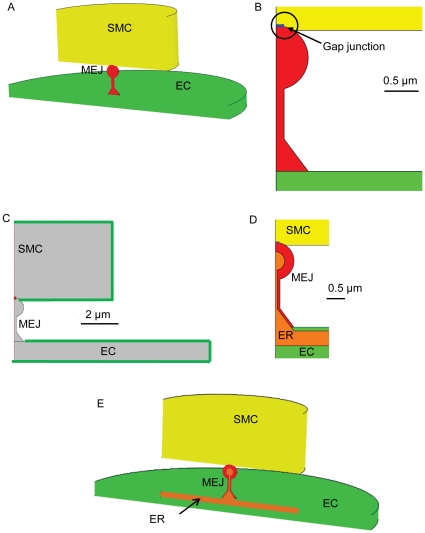
Description of the models.A, B) Model of the interaction between a smooth muscle cell (SMC) and an endothelial cell (EC) through the myoendothelial junction (MEJ). The SMC is shown in yellow, the EC in green and the MEJ in red. The SMC and MEJ are coupled in the area highlighted with the black circle at the blue edge. B,C) The endothelial cell (EC) has a radius of 10 µm and is 1 µm thick. The smooth muscle cell (SMC) has a radius of 5 µm and is 4 µm thick. The head of the MEJ is spherical with a radius of 0.5 µm that is located on top of a neck that is 1.525 µm long. Stimulation was modeled by increasing the concentration at the green boundaries in the respective cell. Scale bars indicate the respective dimensions. D,E) The model was extended to include endoplasmic reticulum (ER) in the EC. The ER had a radius of 6 µm, 0.5 µm thick and located 0.1 µm from the plasma membrane. The SMC is shown in yellow, the EC in green, the MEJ in red and the ER in orange.